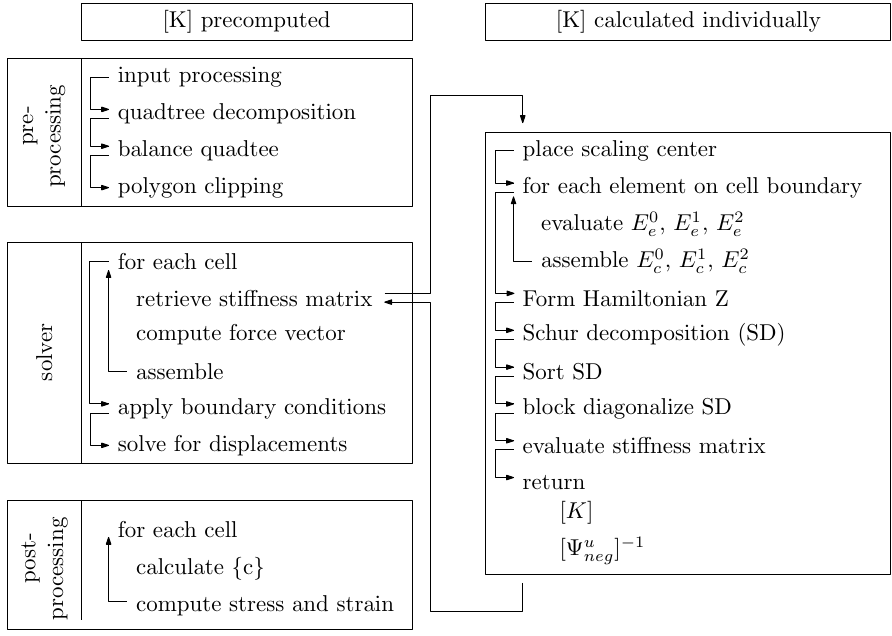
Figure 42. Steps comprising SBFEM